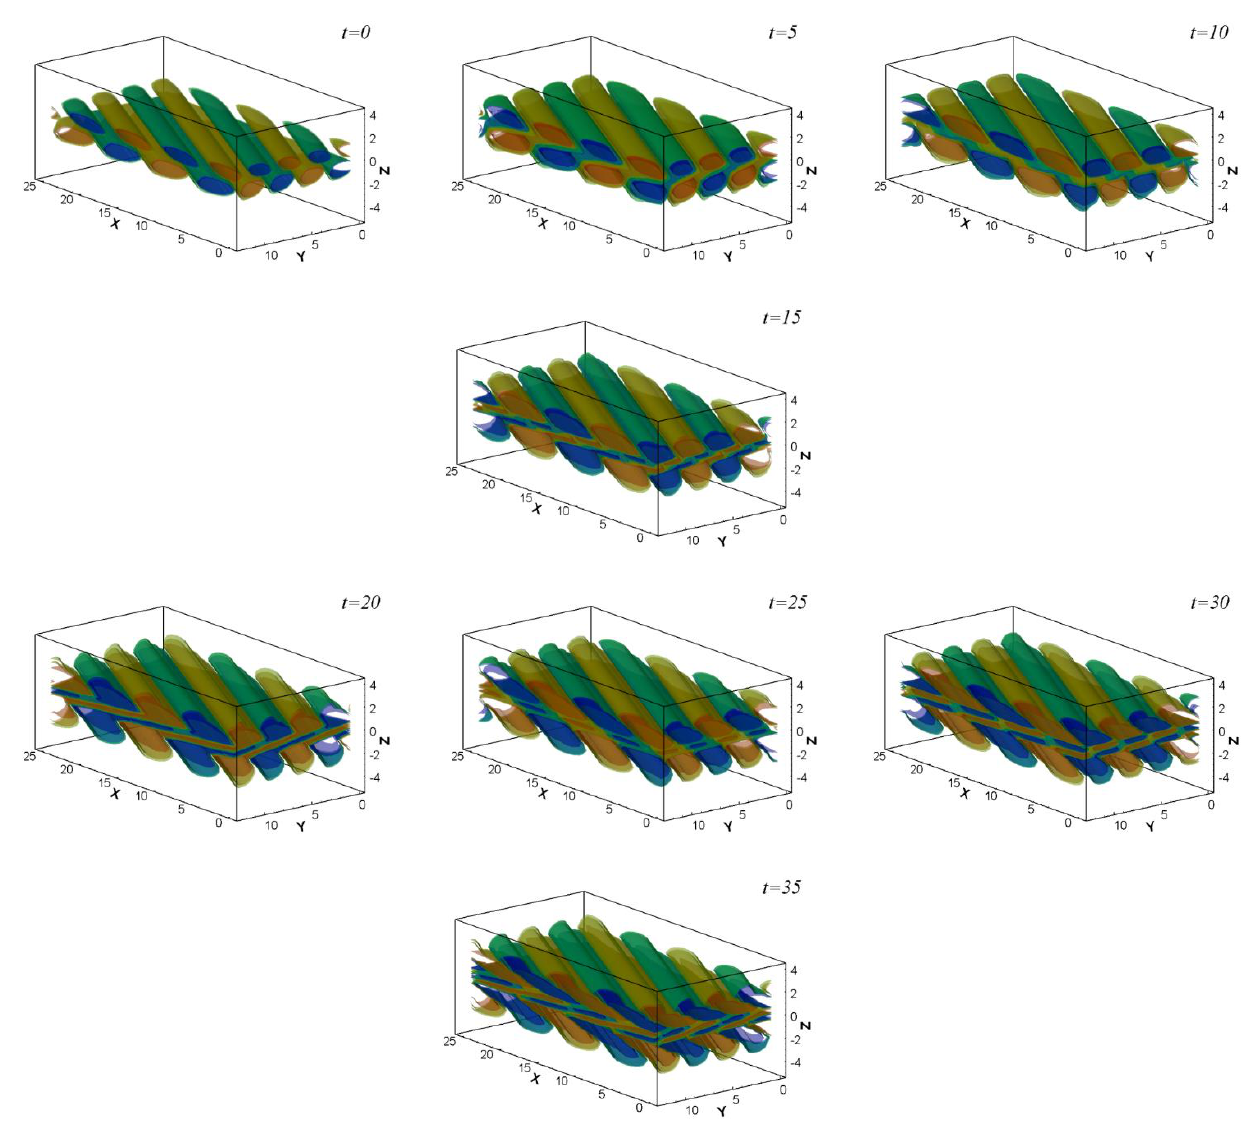
Figure 9. Time evolution of the streamwise velocity component of a three-dimensional optimal vector calculated for the maximal growth at t = 10, Ri = 2, Re = 1000, α = 0.5, β = 1. The growth function increases at t = 0, 5, 20, 35, attains maximal values at t = 10, 25, and decays at t = 15, 30 .